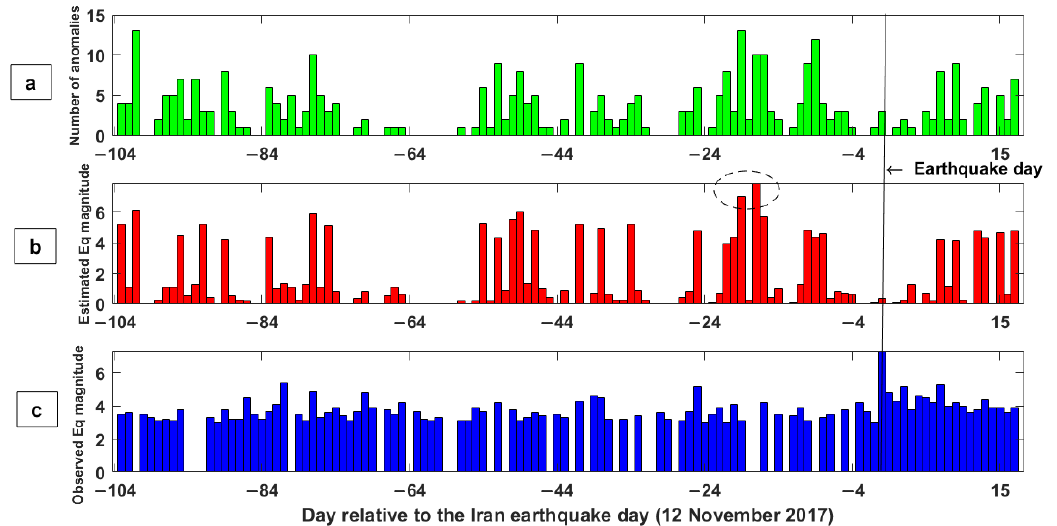
Figure 7. ( a ) Variation in the number of anomalies (green curve), ( b ) variation in the predicted earthquake magnitude (red curve), and ( c ) variation in the observed earthquake magnitude (blue curve) for the Iran earthquake (12 November 2017) from 1 August to 30 November 2017. In both panels, the x -axis represents the day relative to the earthquake day, indicated as a vertical dotted line. Figure 8a indicates the daily variation in the number of anomalies (green curve) and (b) the variation in the predicted earthquake magnitude (red curve) for the Papua New Guinea earthquake (14 May 2019) from 1 January to 30 June 2019. Figure 8a shows that the maximum number of anomalies (N = 21) was observed 32 days prior to the earthquake. FIS predicted an impending earthquake with a magnitude of 9 32, 33, and 35 days before the mainshock.